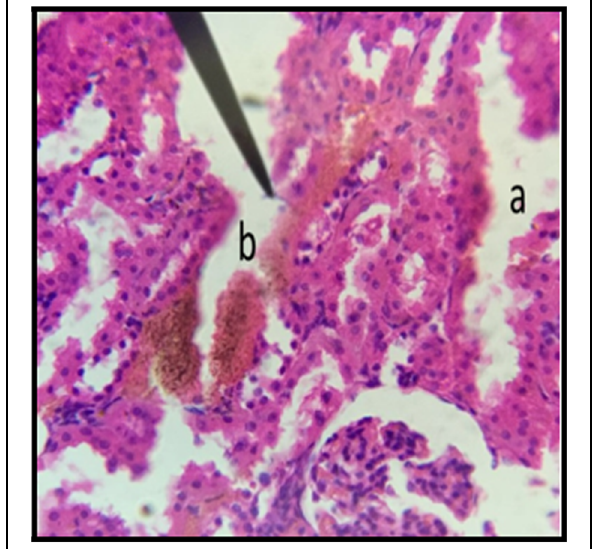
Fig. 12 Liver Section of Female Rat (Control) X400. a normal sinusoids and hepatocytes